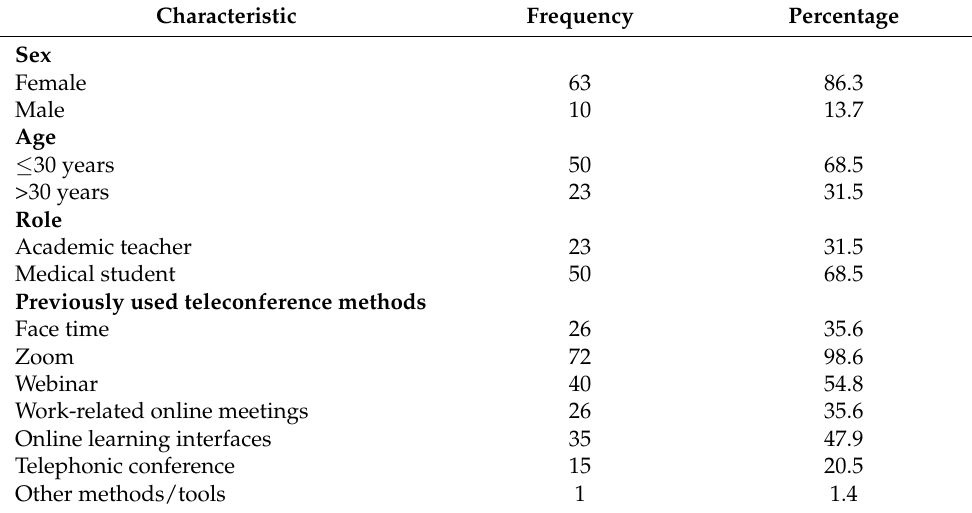
Table 1. The e-OSCE survey participating subjects characteristics ( n =